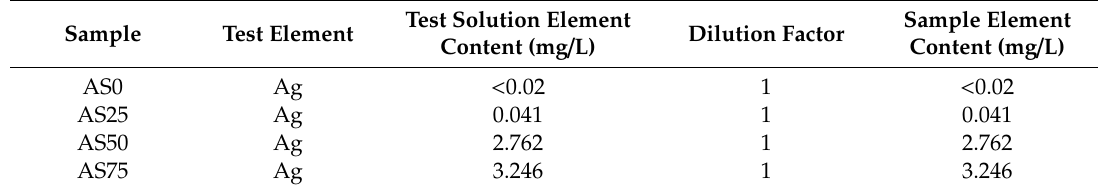
Table 4. Analysis of silver ion release concentration of hydrogel in water by ICP (Inductively coupled plasma).